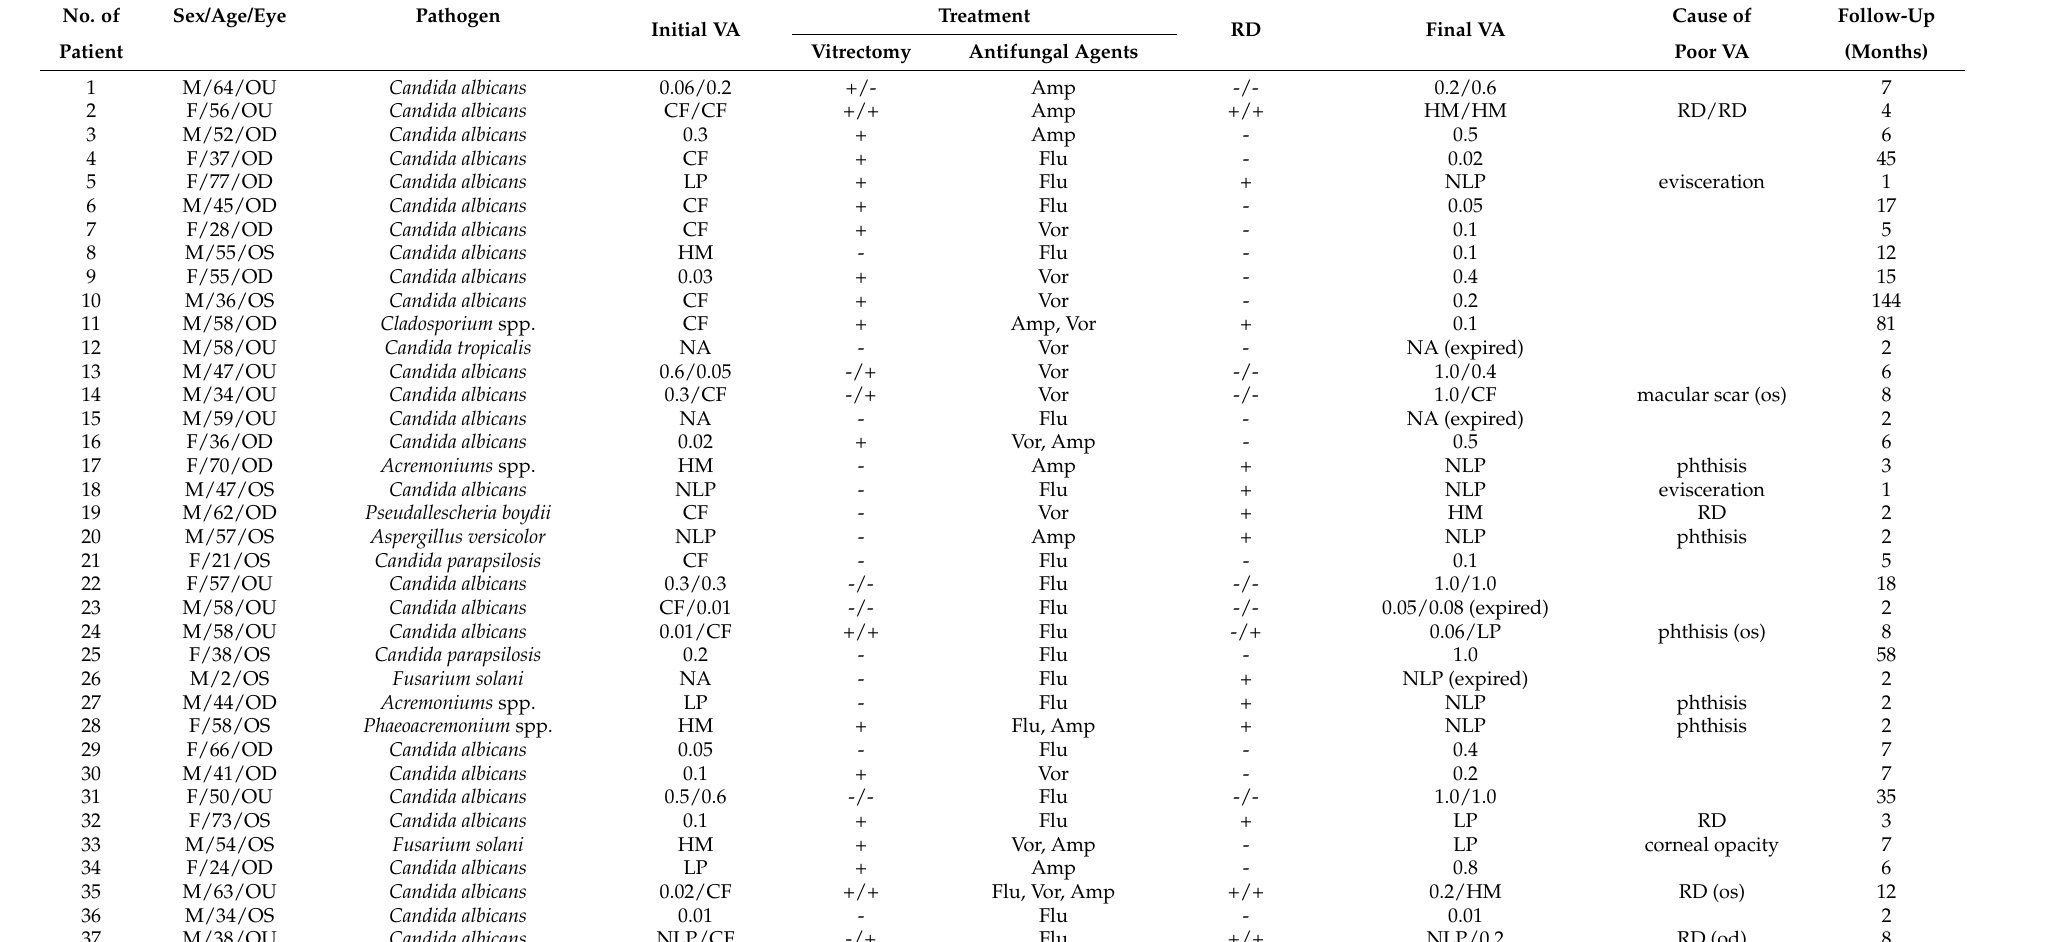
Table 4. Visual outcomes and treatment in patients with exogenous fungal